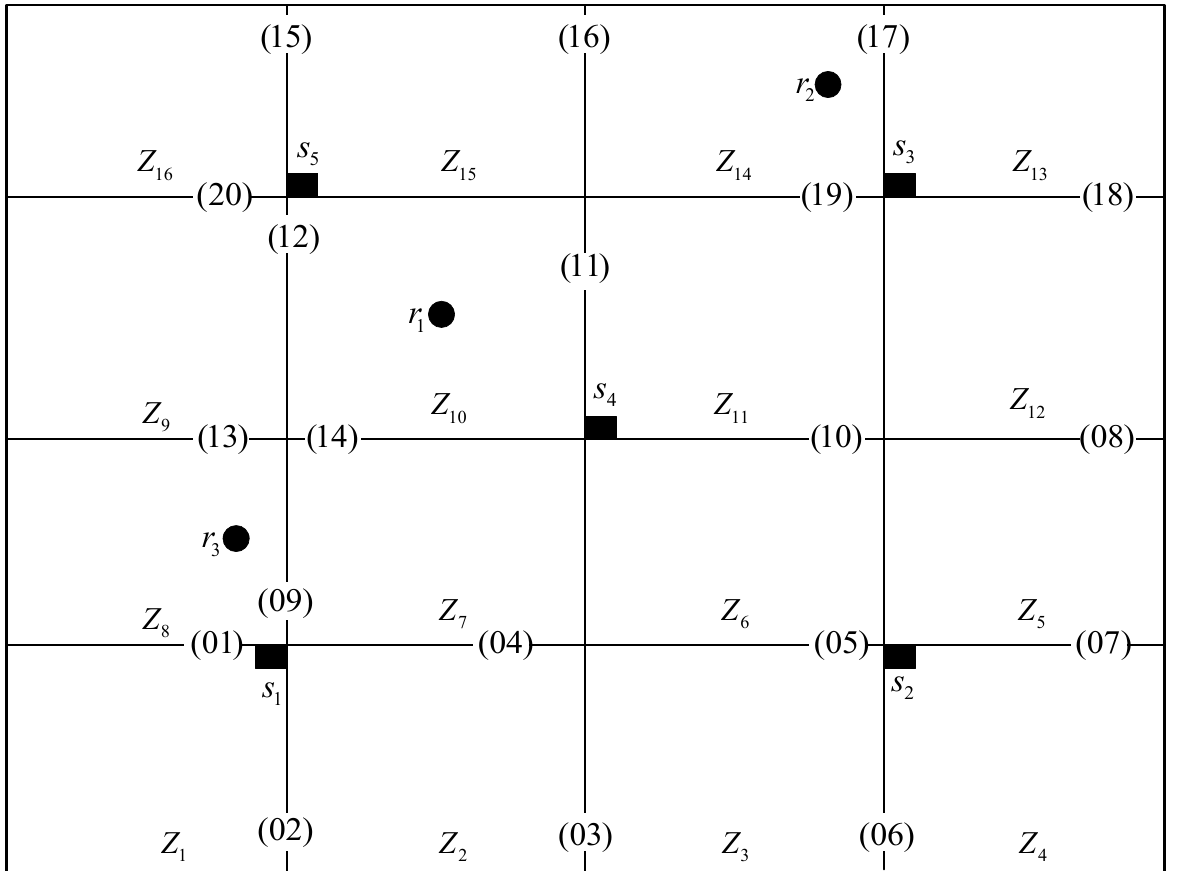
Figure 7. Service space of Simulation. Figure 7.